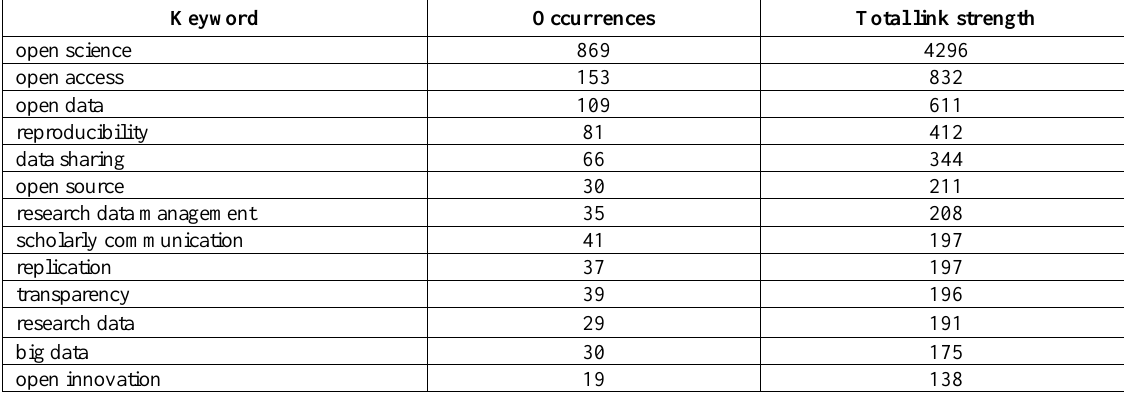
Source: Compiled by the authors using VOSViewer (VOSViewer,